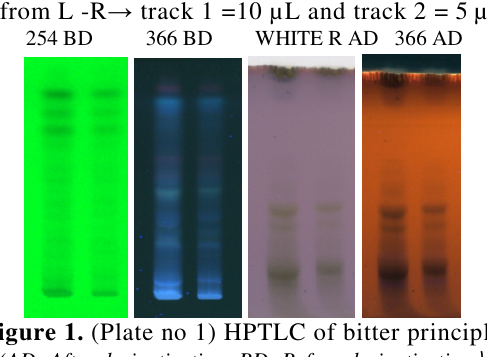
(from L -R → track 1 =10 µL and track 2 = 5